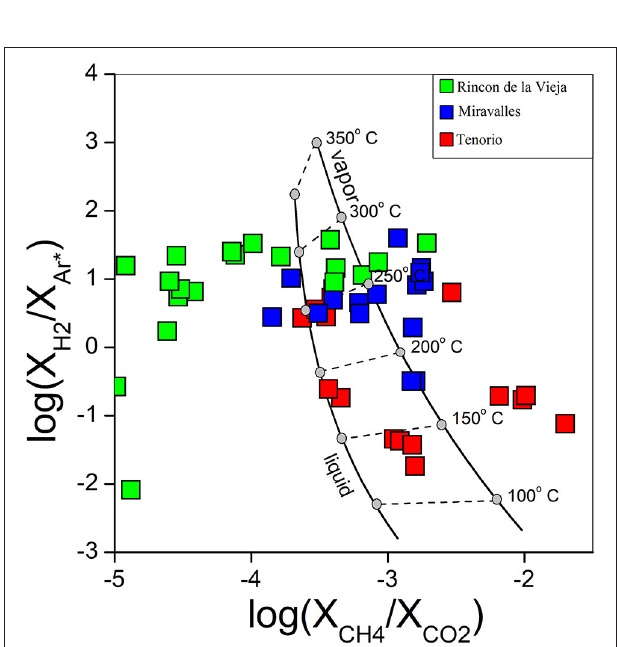
FIGURE 5 | Log(X H2 /X Ar* ) vs. log(X CH4 /X CO2 ) binary diagram. Symbols as in Figure 1